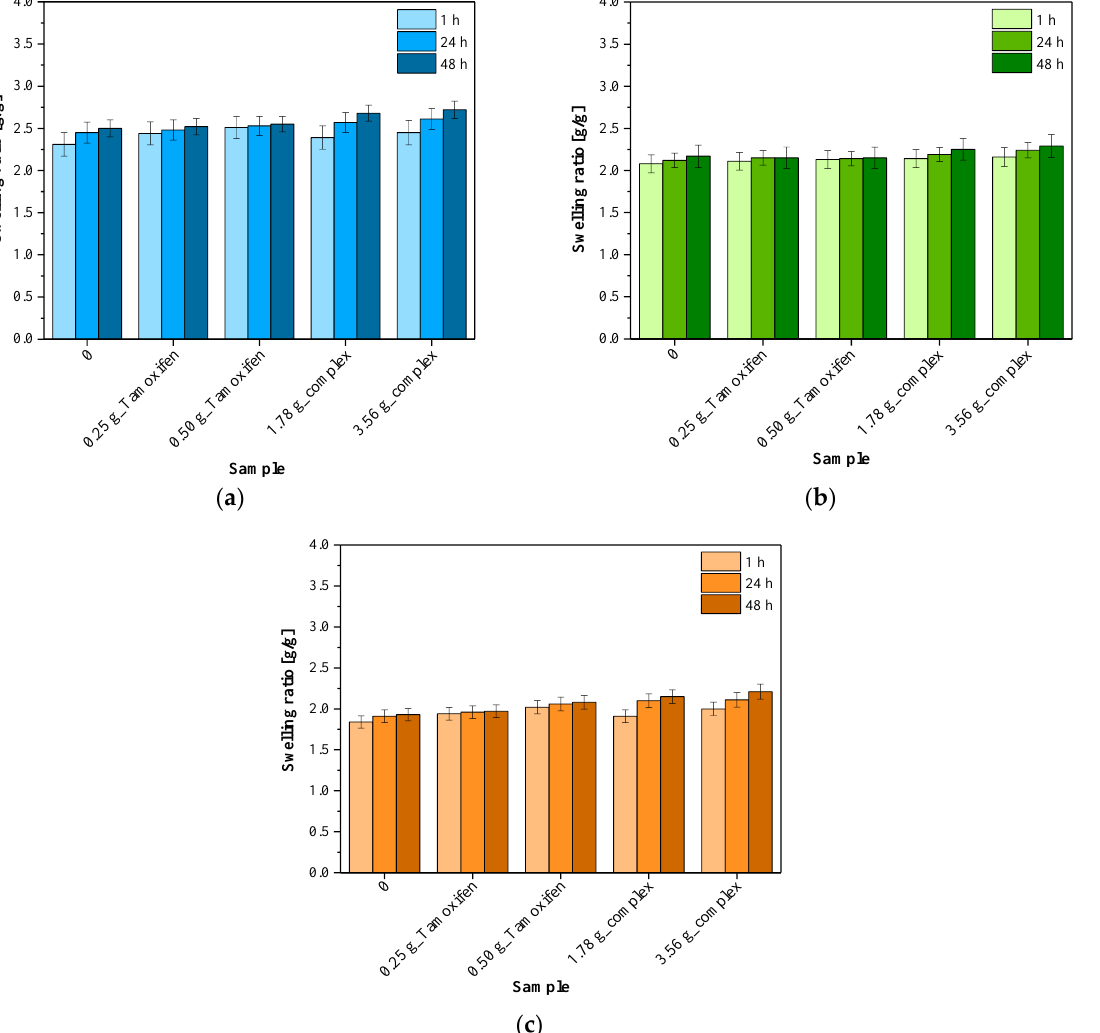
Figure 7. Results of swelling studies of hydrogels in distilled water ( a ), Ringer liquid ( b ) and SBF ( c ) (n — number of repetitions, n = 3) .